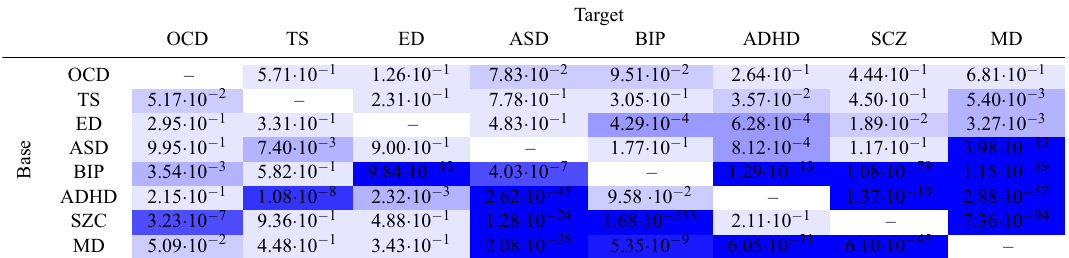
Table 7. Using our method to perform PRS comparisons across eight neuropsychiatric disorders. We further applied our method to the summary statistics of eight neuropsychiatric disorders from PGC (see table 6 for details). For each disorder, we used PGC GWAS summary statistics to compute the group mean and standard deviation of PRS for the other seven disorders. All group PRS were estimated using independent SNPs with p < 10 − 5 in the base summary statistics. We report p -values from a t -test comparing the group mean PRS of cases against controls in the target study, and cells with deeper blue colors correspond to lower p -values. The threshold of significance under multiple testing correction is p < 8.93